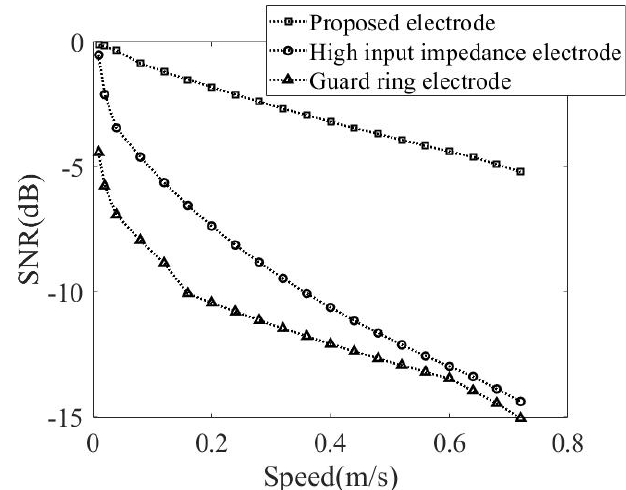
Figure 14. Comparison of SNR versus the speed at which the simulated noise source approaches the subject.